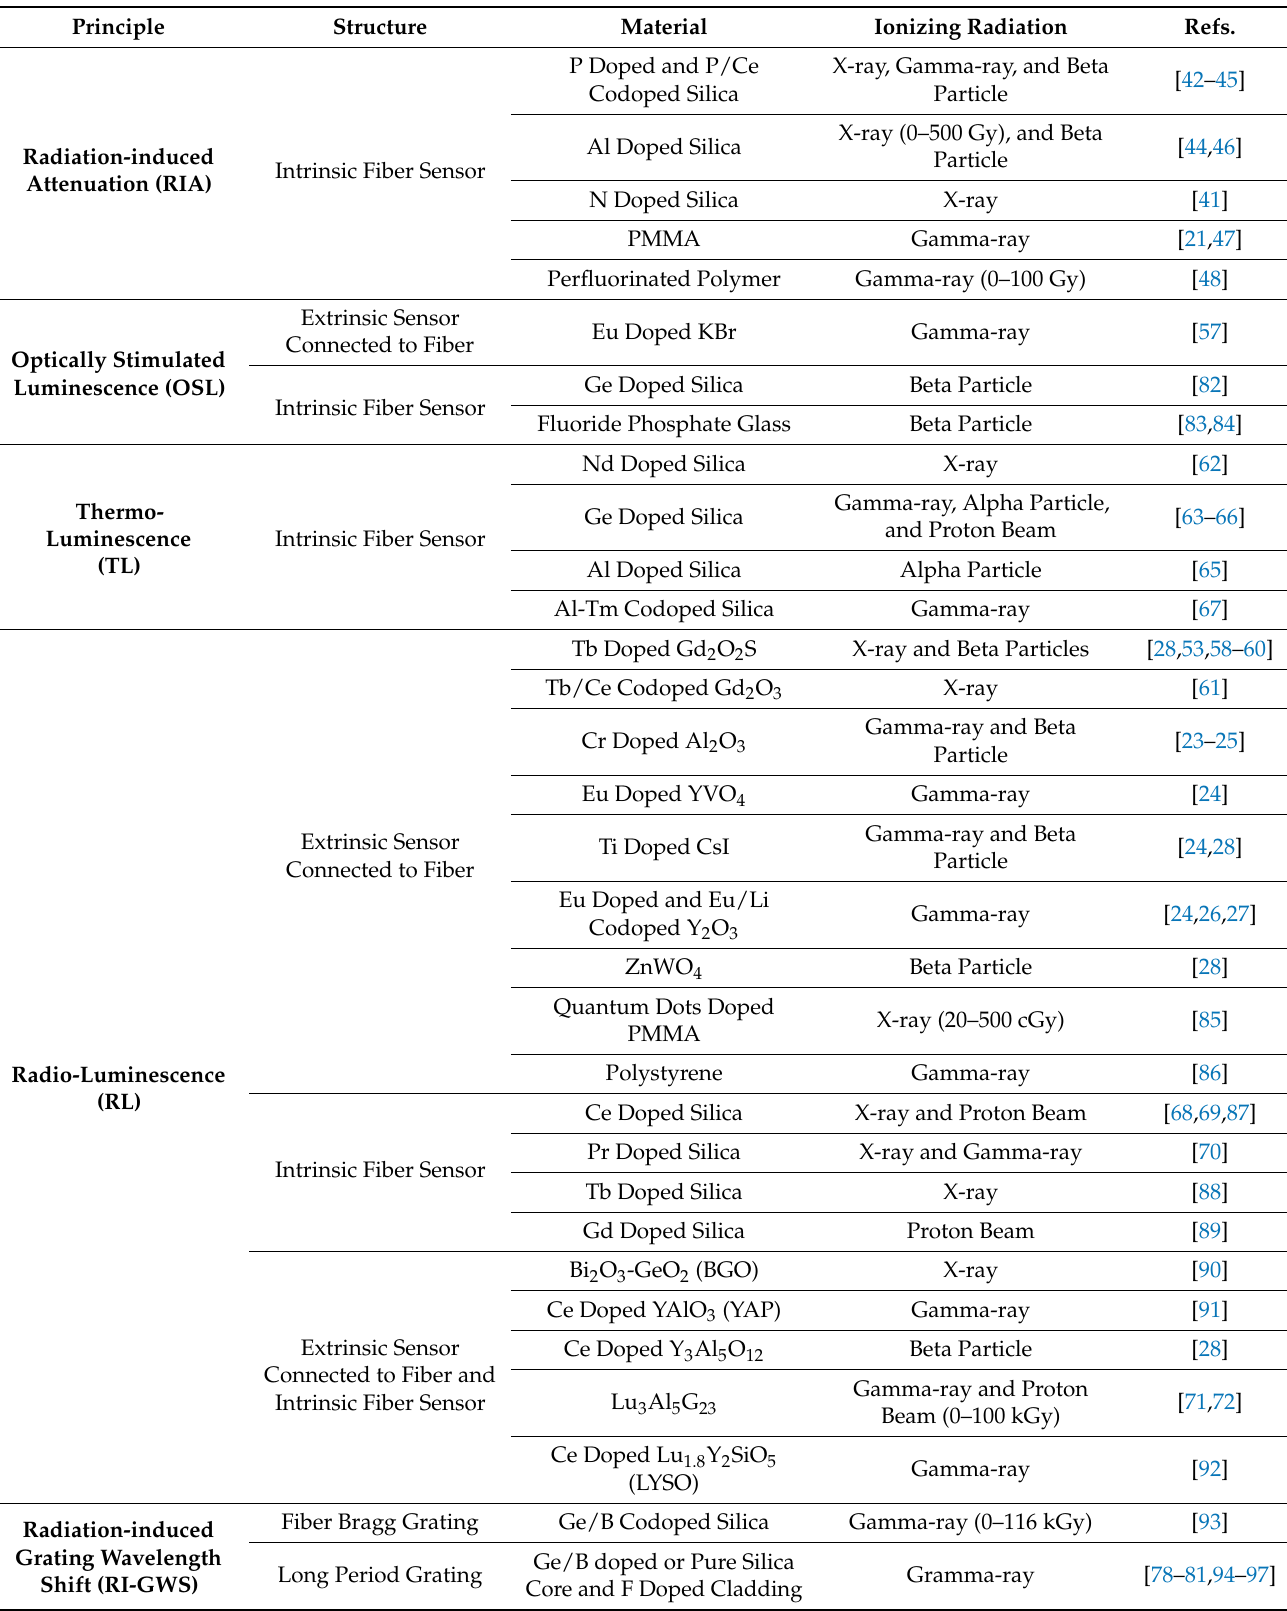
Table 1. Fiber-based Radiation